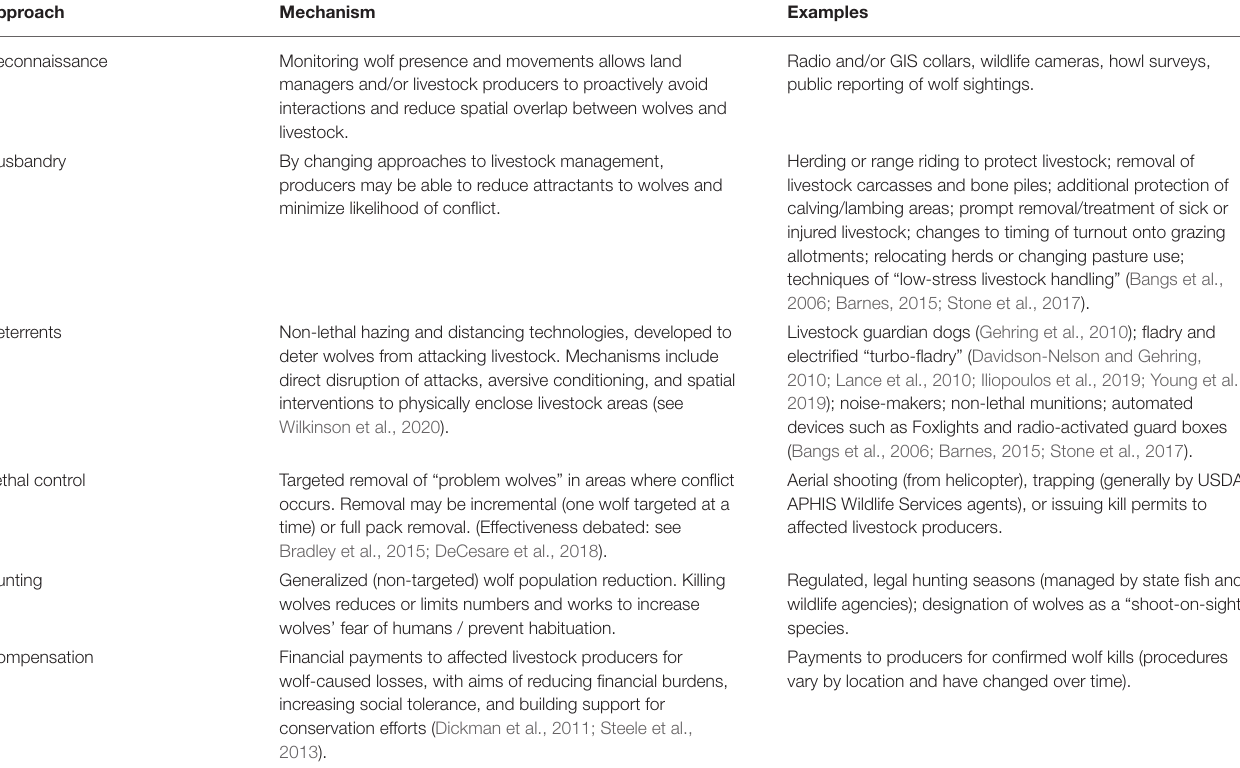
TABLE 2 | Tools and techniques: wolf conflict management across western U.S. national forests.